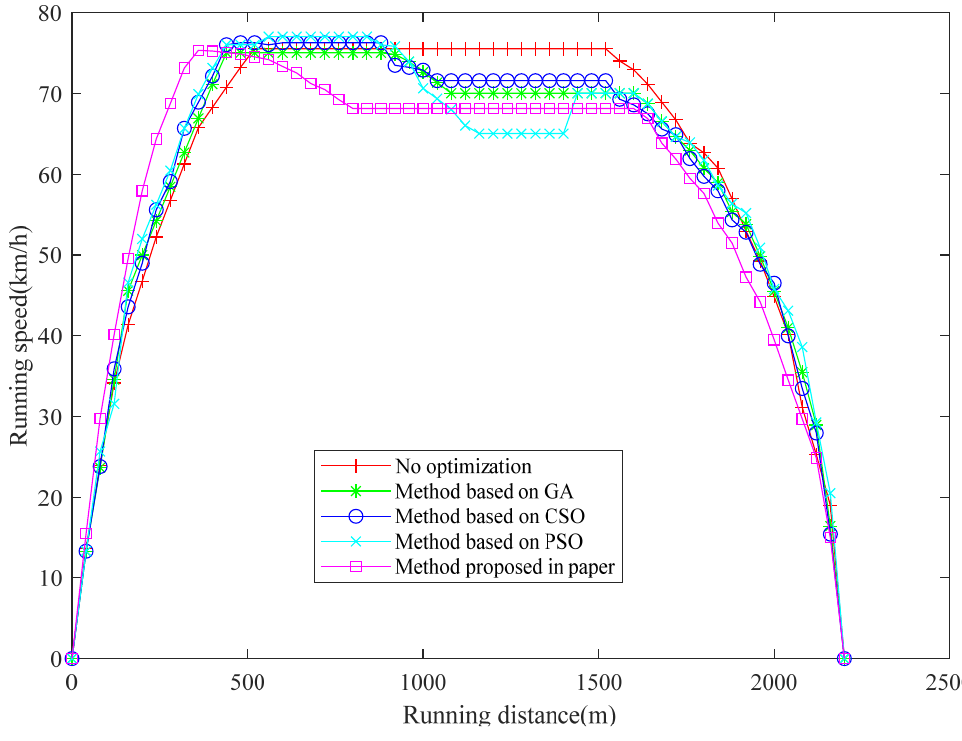
Figure 3. Running distance and running speed.